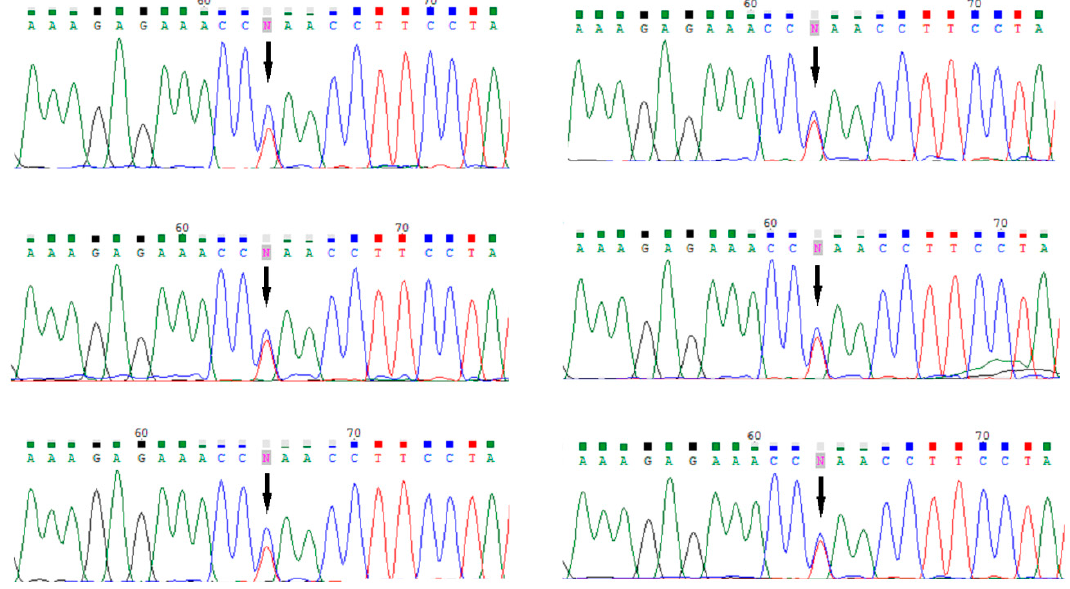
Figure 1. Loss of heterozygosity (LOH) analysis in breast cancer tissues from six carriers of BLM mutation; retention of the wild type BLM allele in breast cancer seen in six tested tumor samples. The p.Gln548Ter BLM mutation is indicated by arrow ( ↓ ).